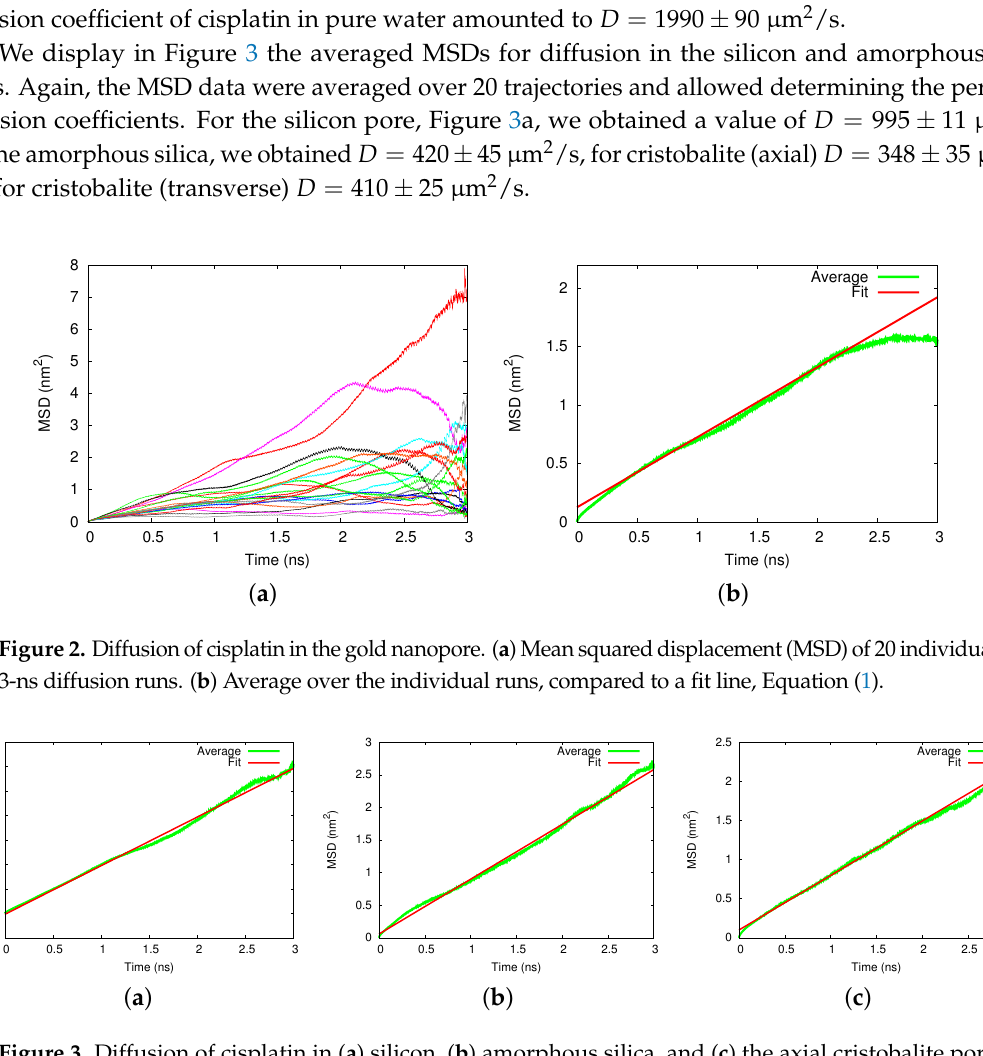
Figure 3. Diffusion of cisplatin in ( a ) silicon, ( b ) amorphous silica, and ( c ) the axial cristobalite pore. MSD, averaged over 20 individual 3-ns diffusion runs, are compared to a fit line, Equation